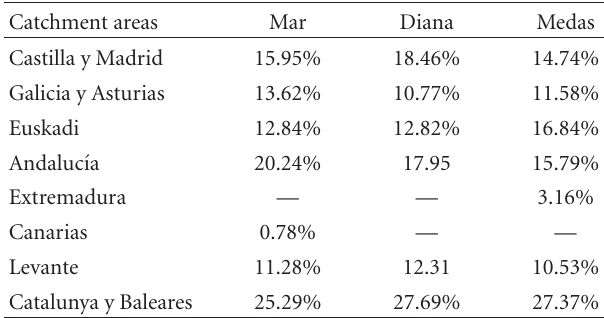
Table 2: Catchement areas and psychiatrists. Catchment